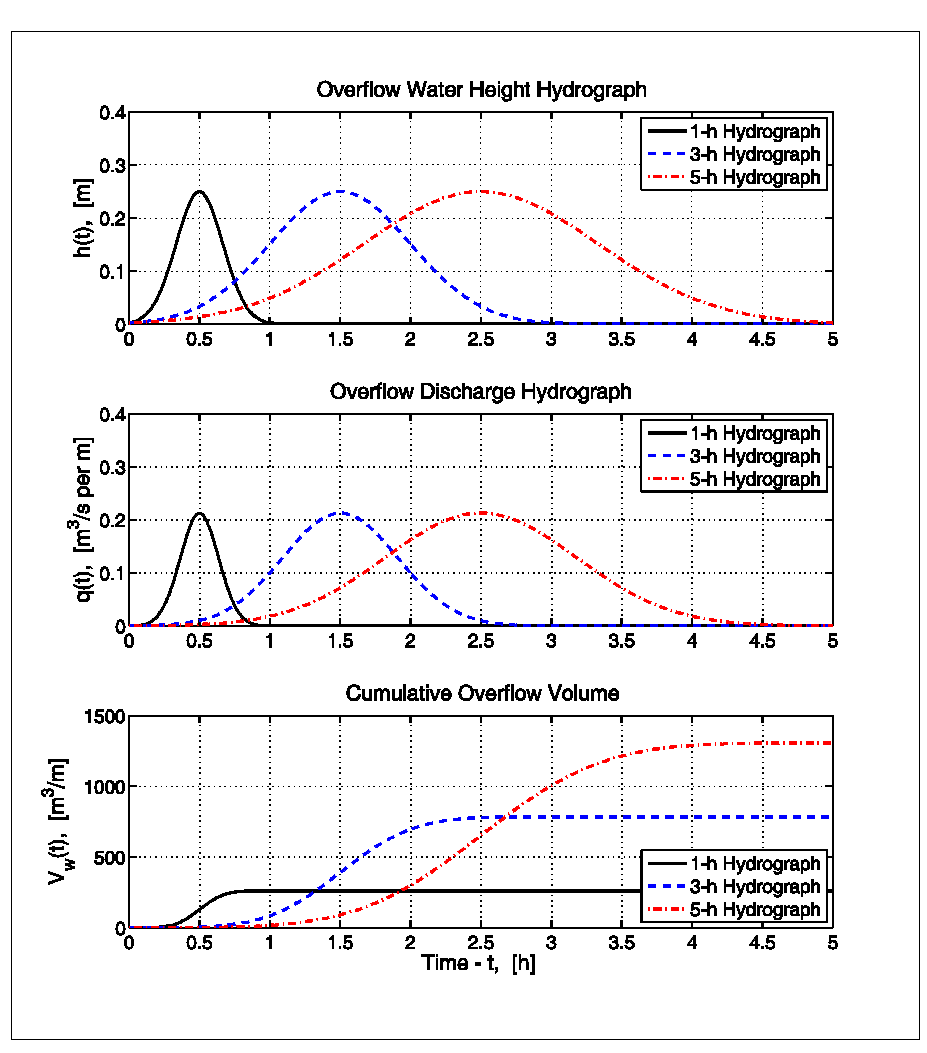
Figure 5. Idealized overflow hydrographs and cumulative overflow water